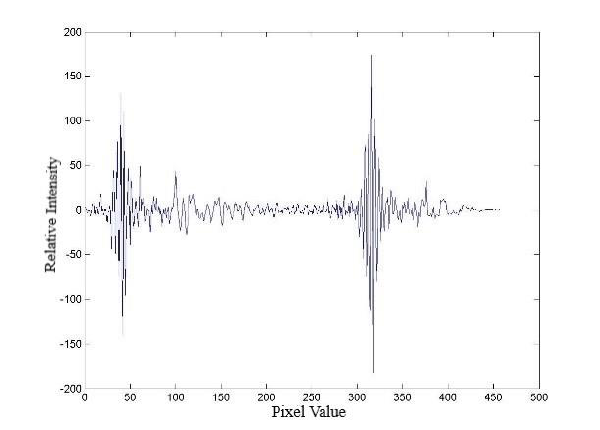
Figure 10. Phase correction interferogram